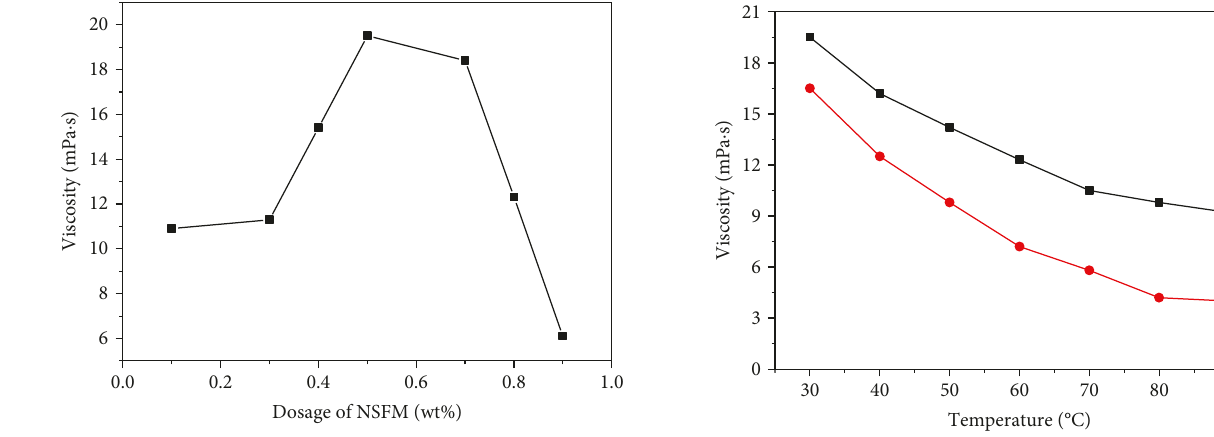
Figure 3: E ff ect of the dosage of NSFM on the performance of AM/DMAEMA/NSFM; [AM] +[DMAEMA] =2.5mol/L, [AM] :